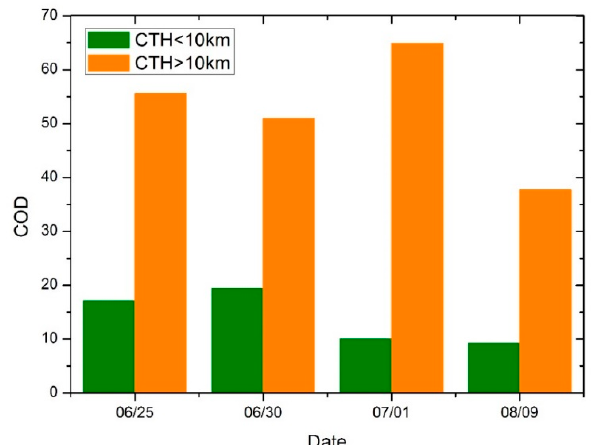
Figure 14. Comparison of the cloud optical depth (COD) over the CTH > 10 km region (orange bar) and CTH < 10 km region (green bar). Histograms are for 25 June, 30 June, 1 July and 9 August 2021.